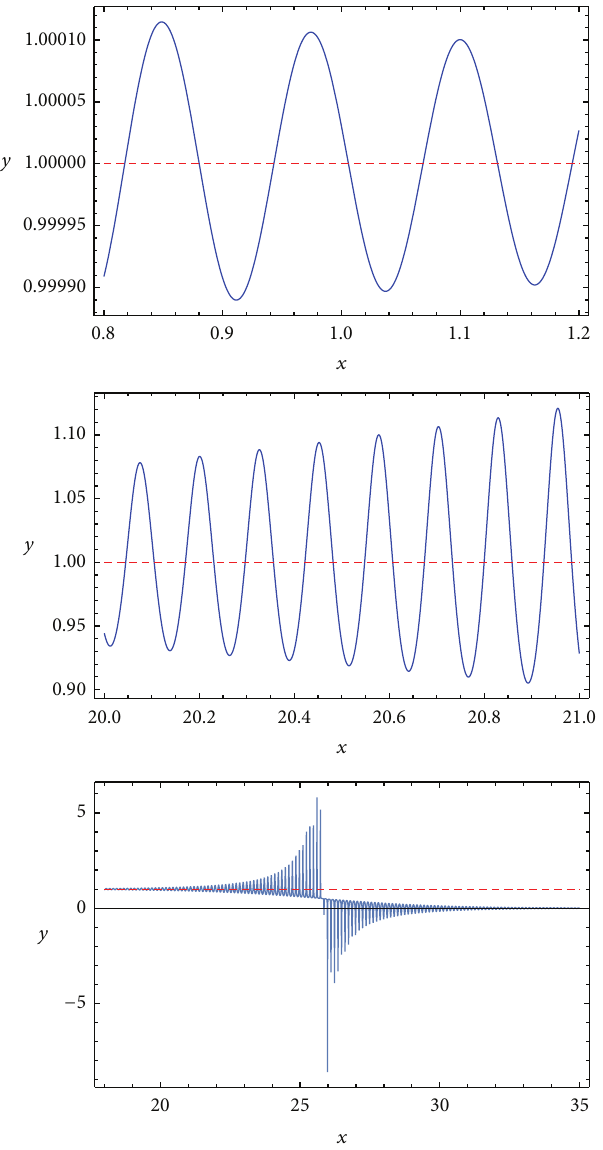
Figure 2: A typical form of the instantaneous mass 𝑚 𝜙 (𝑡) as a function of time obtained for 𝜔 BW (𝑚) . Axes: 𝑦 = 𝜅(𝑡) , where 𝜅(𝑡) is defined by (16); 𝑥 = 𝑡/𝜏 𝜙 : time is measured in lifetimes. The horizontal dashed line represents the value of 𝑚 0 𝜙 (𝑡) = 𝑀 0 𝜙